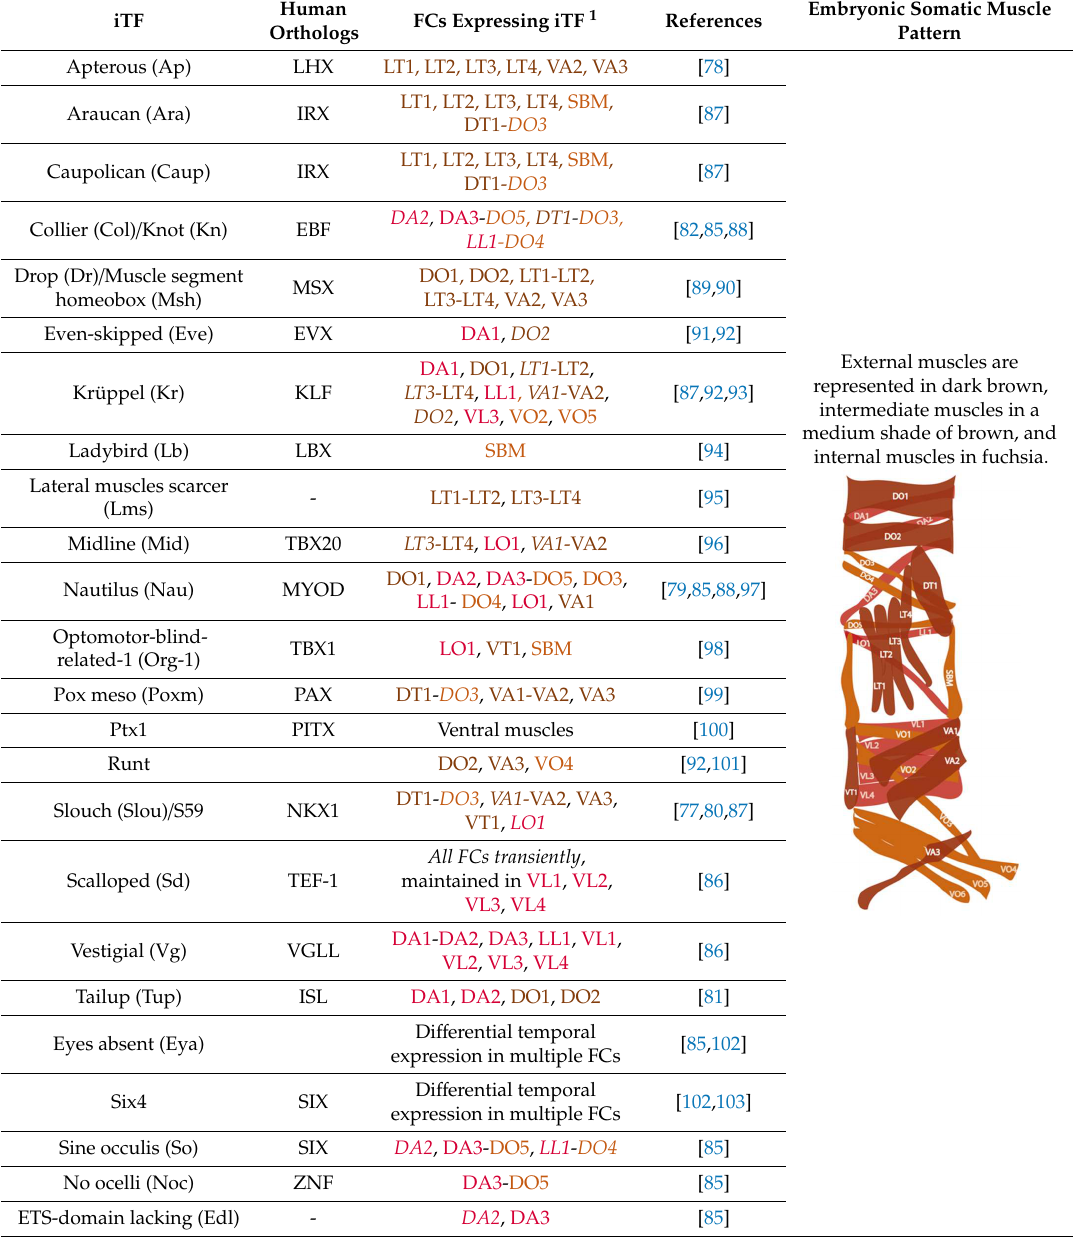
Table 1. The iTF expression patterns in embryonic somatic muscle founder cells.